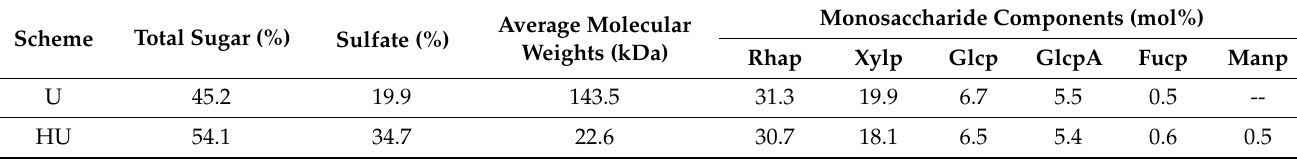
Table 1. Chemical components of U and